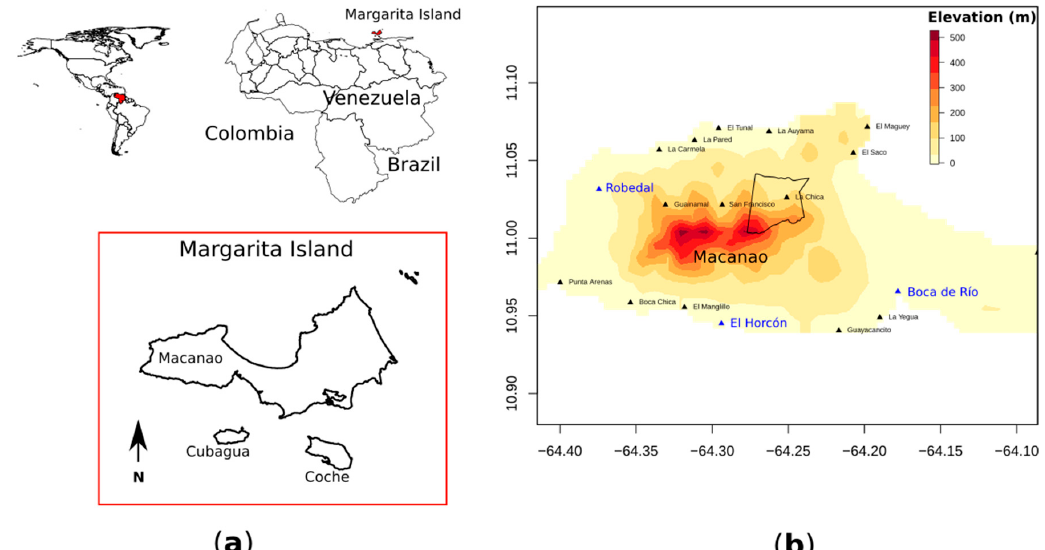
Figure 1. Study area. ( a ) Relative position of Venezuela, Margarita Island, and the Macanao Peninsula. ( b ) Elevation gradient in Macanao. Communities surveyed are highlighted in blue. The main nesting site where Provita implements nest monitoring and surveillance, Hato San Francisco, Quebrada La Chica, is delimited by a black polygon.